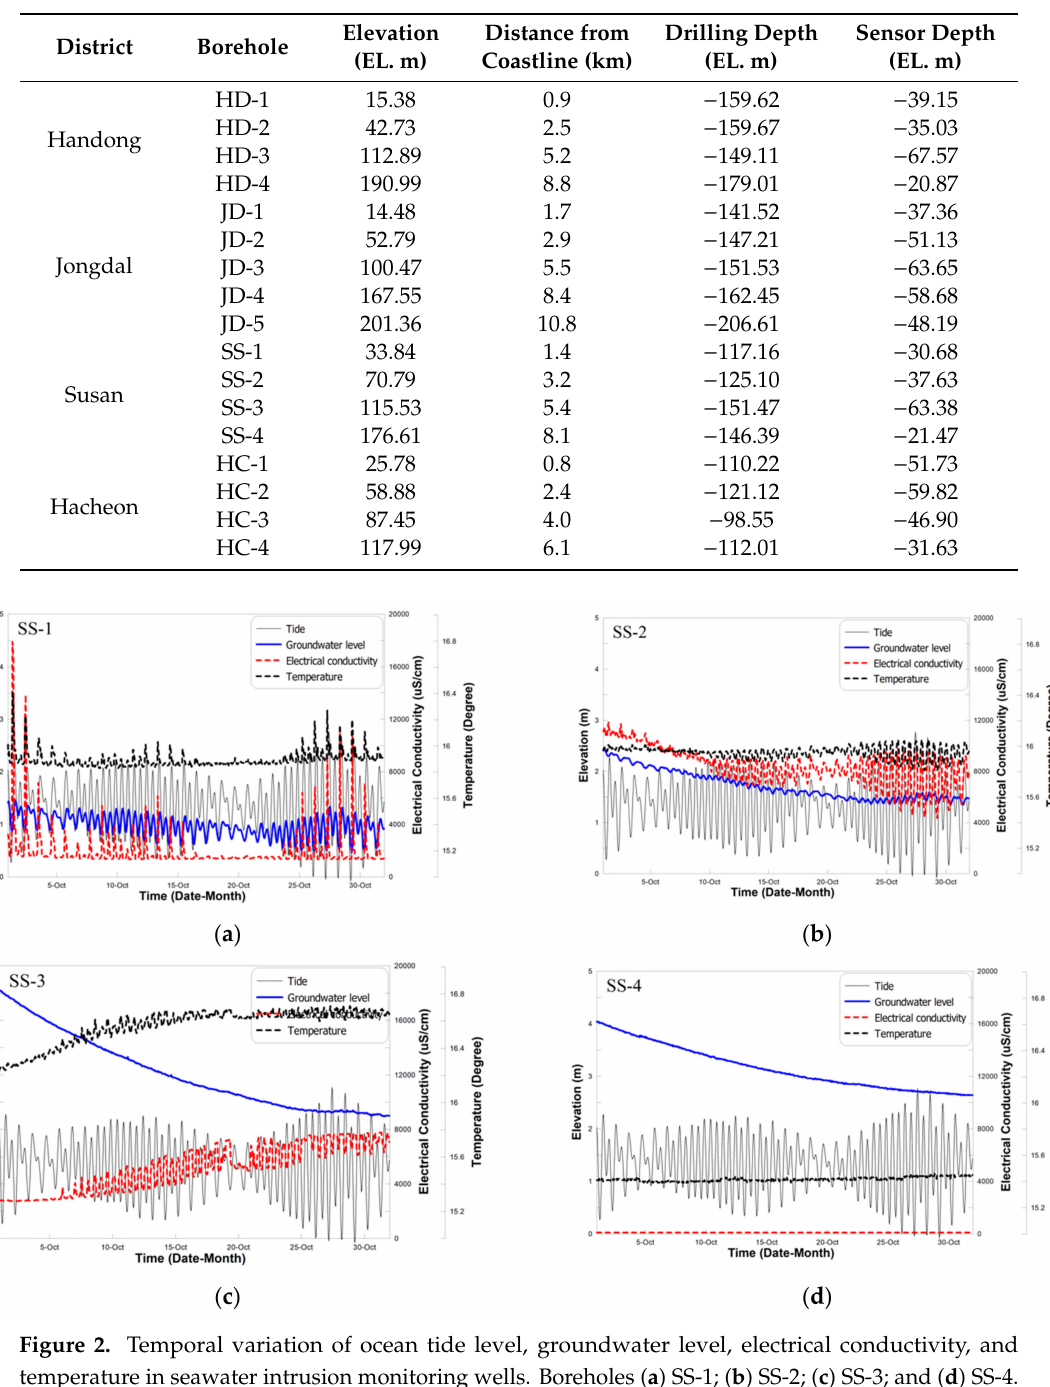
Table 1. Details of seawater intrusion monitoring wells in the eastern part of Jeju Island. EL. m, means above mean sea level (amsl).